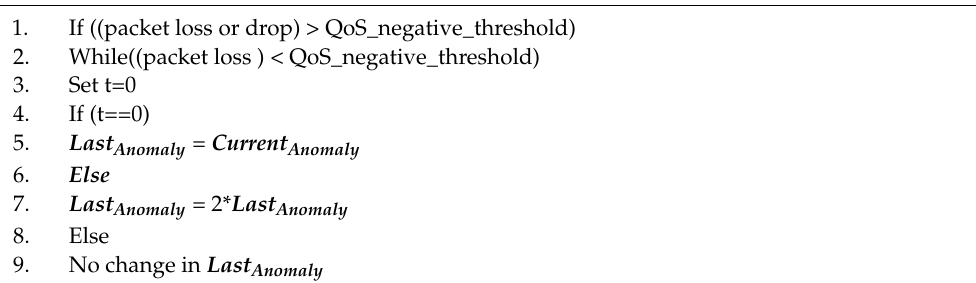
Algorithm 3: Threshold limit for a local event if packet loss is